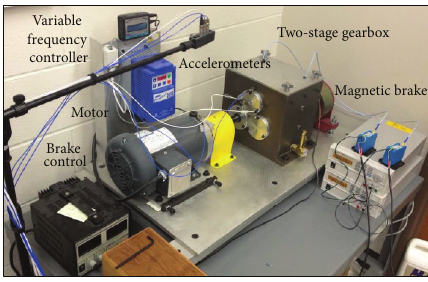
Figure 1: Gearbox test